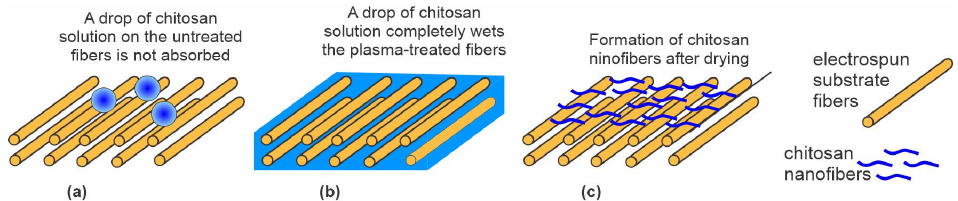
Figure 5. The effect of plasma treatment on the soaking properties of electrospun fiber cloth. ( a ) Droplets of chitosan solution remain on the untreated cloth surface after dipping into a chitosan solution; ( b ) plasma-treated cloth absorbs the solution within a few seconds of dipping; and ( c ) chitosan nanofibers are formed on the freeze-dried samples.